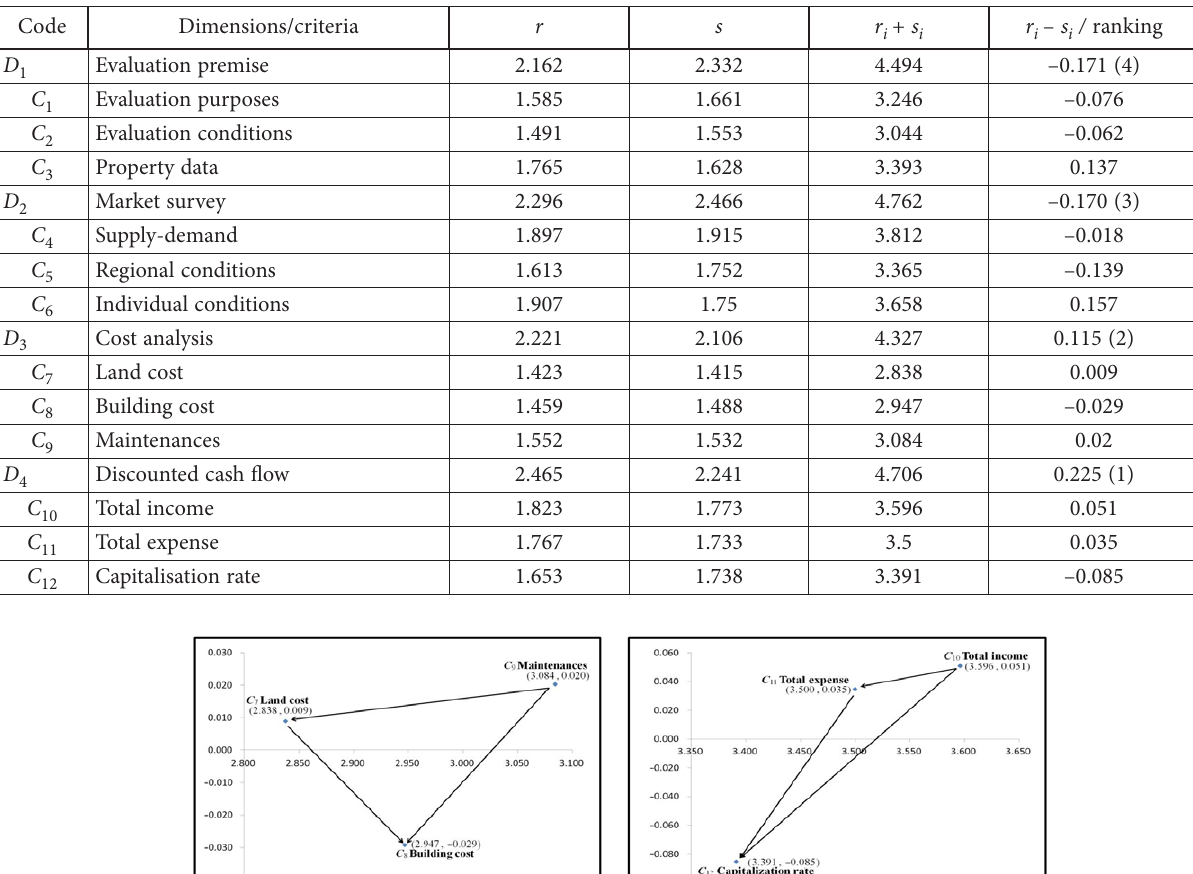
Table 3. Result of dimensions/criteria analysis